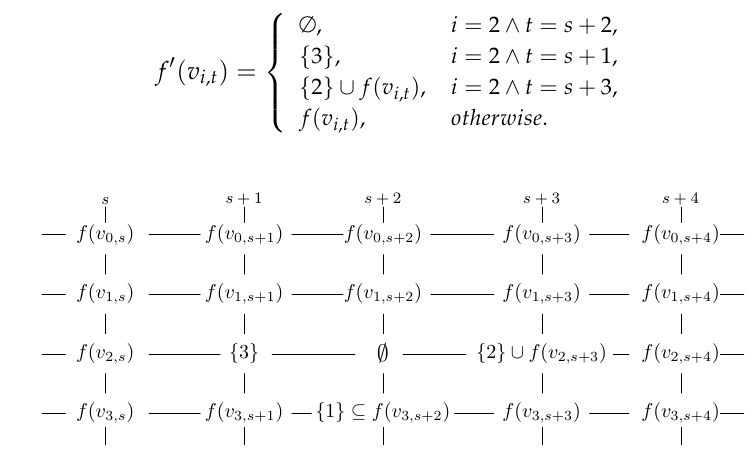
Figure 17. Sketch of f ′ Figure 17. The sketch of f (cid:48) in Lemma